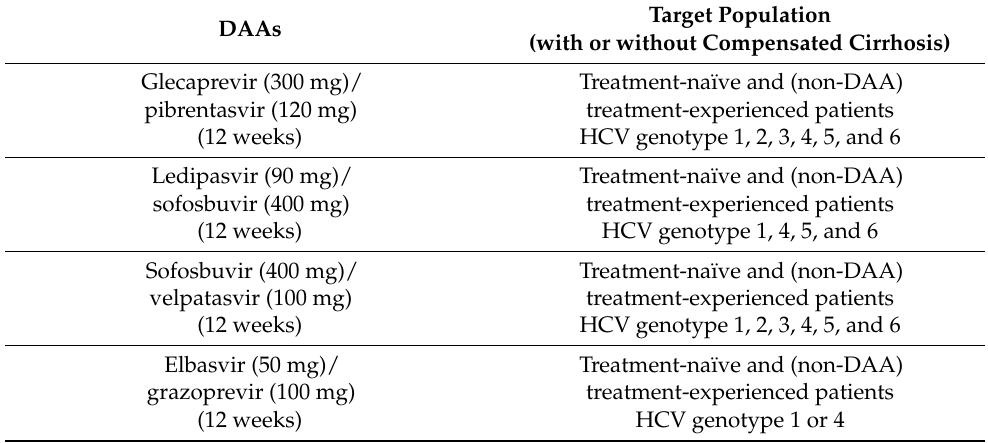
Table 1. Combinations of direct-acting antiviral agents (DAAs) for therapy of hepatitis C virus (HCV) in patients with chronic kidney disease (CKD) stage 3/4 (estimated glomerular filtration rate (eGFR) < 30 mL/min/1.73 mq 2 ) (dialysis dependent or